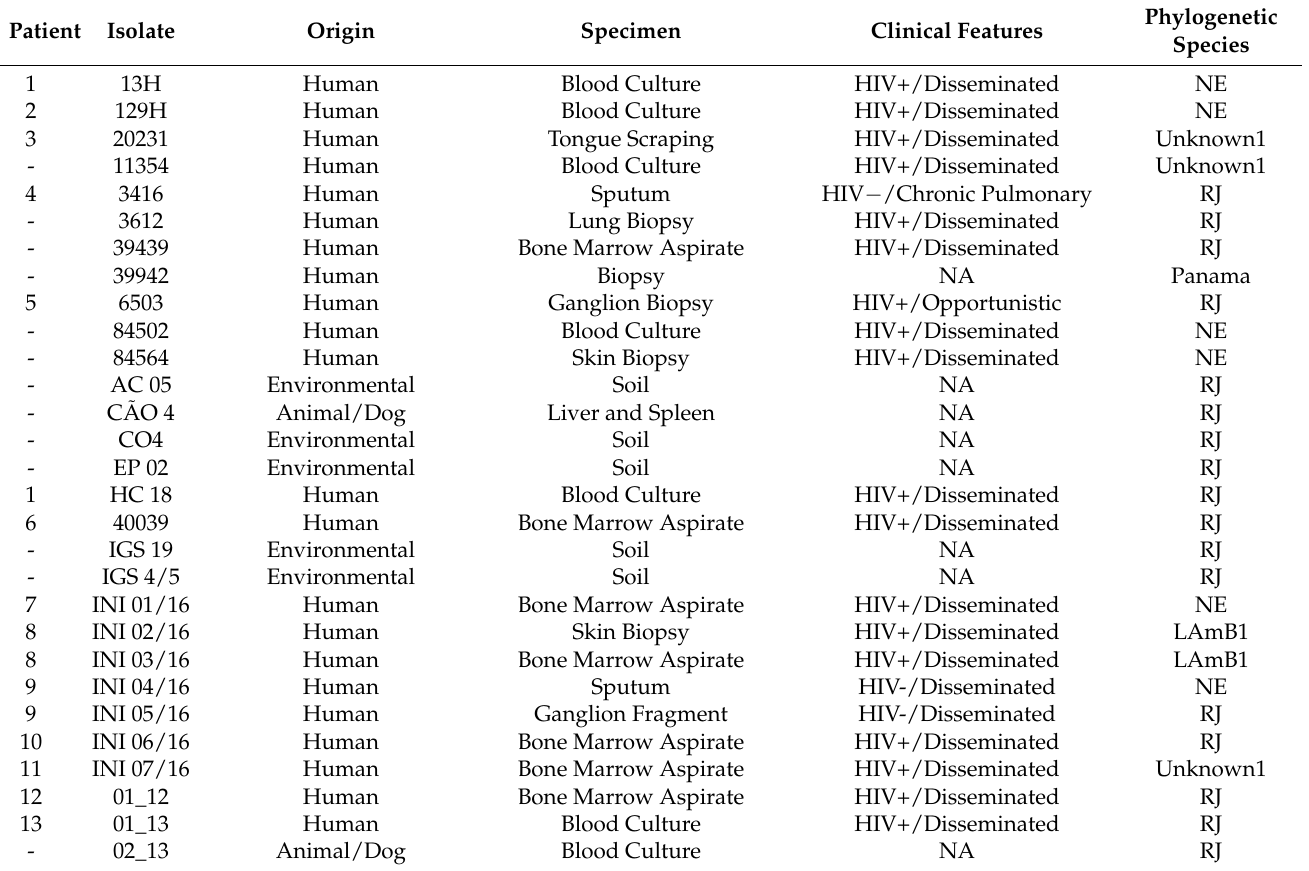
Table 1. General information of the 50 studied isolates in this